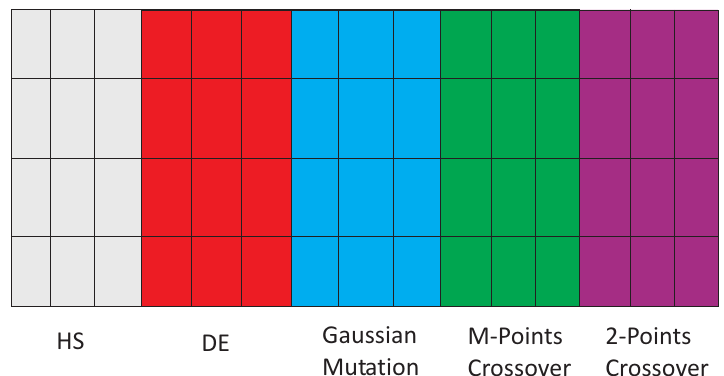
Figure 3. Example of different substrate layers in the Coral Reefs Optimization algorithm with Substrate Layers (CRO-SL) algorithm. HS, Harmony Search; DE, Differential